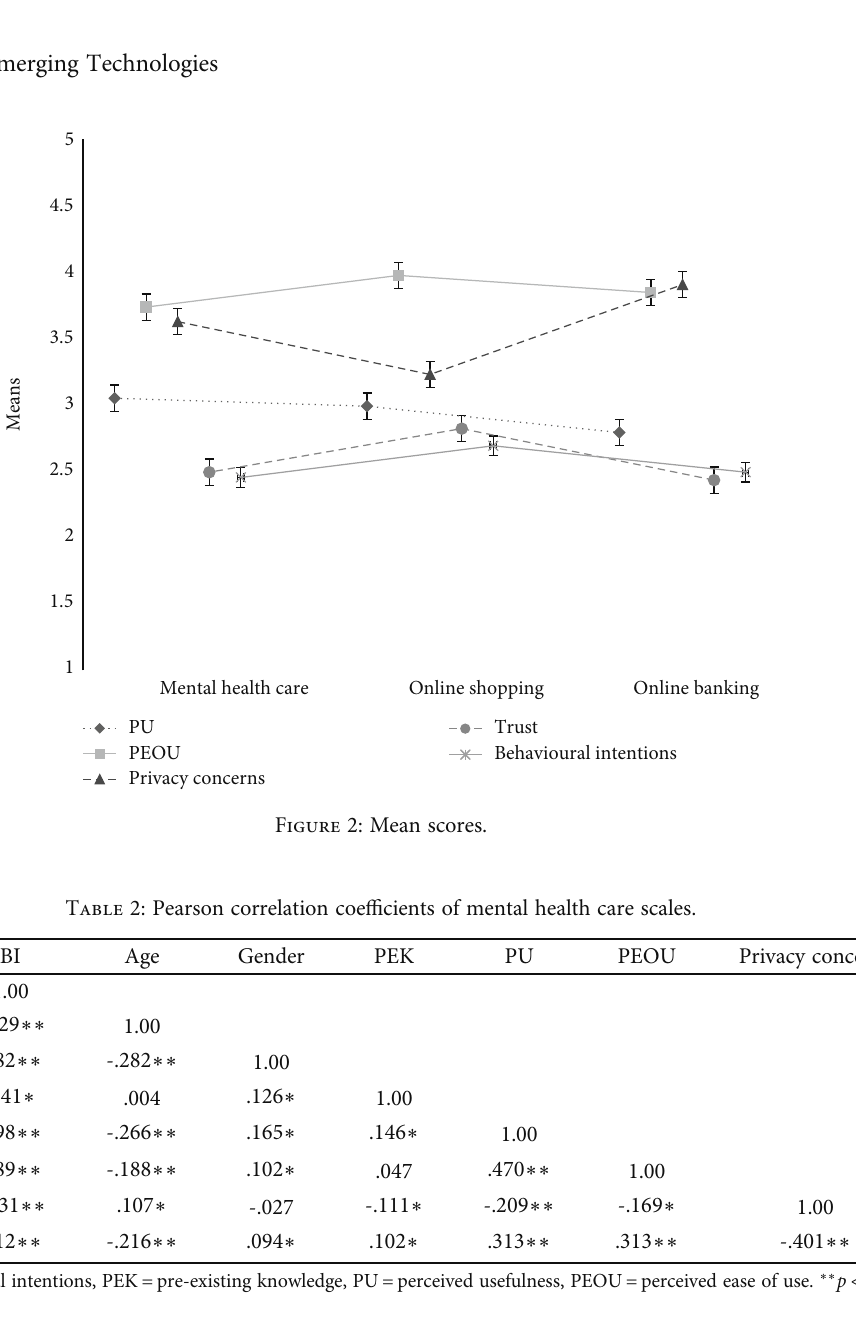
Table 3: Pearson correlation coe ffi cients of online shopping